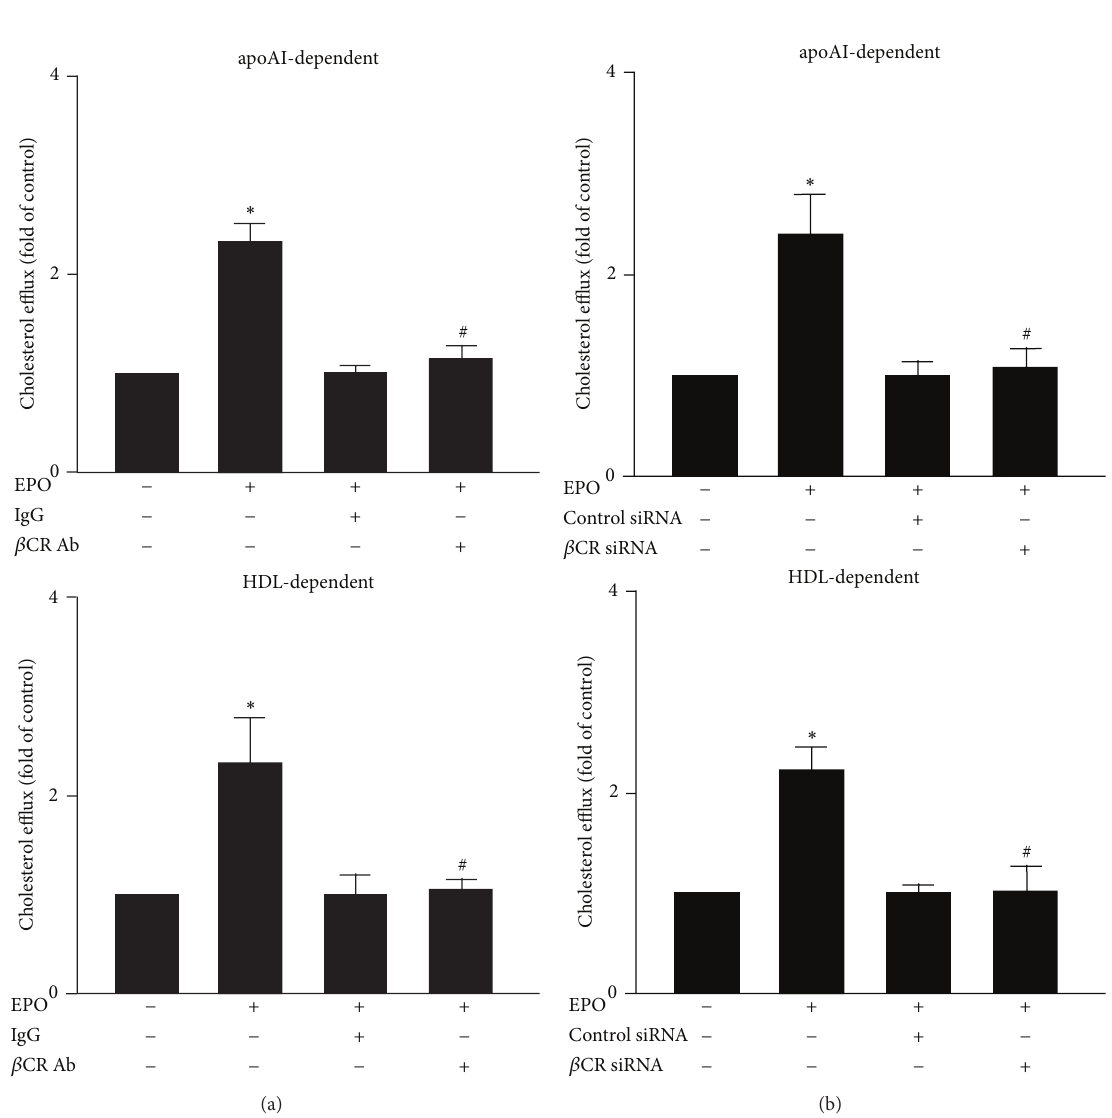
Figure 6: Inhibition of 𝛽 CR activation abolishes the EPO-mediated promotion of cholesterol efflux in macrophages. Bone-marrow-derived macrophages were pretreated with IgG (200ng/mL) or 𝛽 CR neutralizing Ab (200ng/mL) for 2 h (b) transfection with control siRNA (50 nmole/L) or 𝛽 CR siRNA (50 nmole/L) for 24 h and then treated with EPO (5 U/mL) for 12h, followed by NBD-cholesterol (1 𝜇 g/mL) for additional 6h in the absence or presence of apoAI (10 𝜇 g/mL) or HDL (50 𝜇 g/mL). The medium and cell lysates were collected for the measurement of fluorescence. The calculation of cholesterol efflux is defined as fluorescence in the medium relative to the total amount of fluorescence. Data are mean ± SEM from 5 independent experiments. ∗ 𝑃 < 0.05 versus vehicle-treated group, # 𝑃 < 0.05 versus EPO-treated